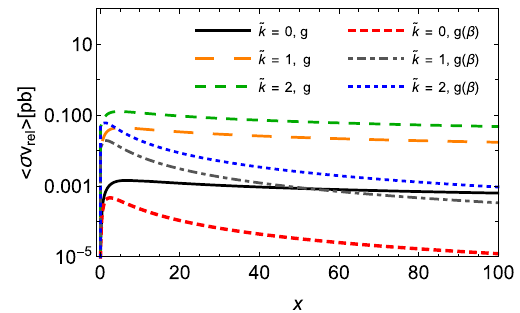
Fig. 5 Thermally averaged cross section for spin-half monopole pair annihilation M ¯ M → q ¯ q as a function of x = M / T , at the fixed value of the monopole mass M = 5 TeV, but taking a velocity (β) dependent coupling, g (β) , and different values of the normalized parameter ˜ κ = κ